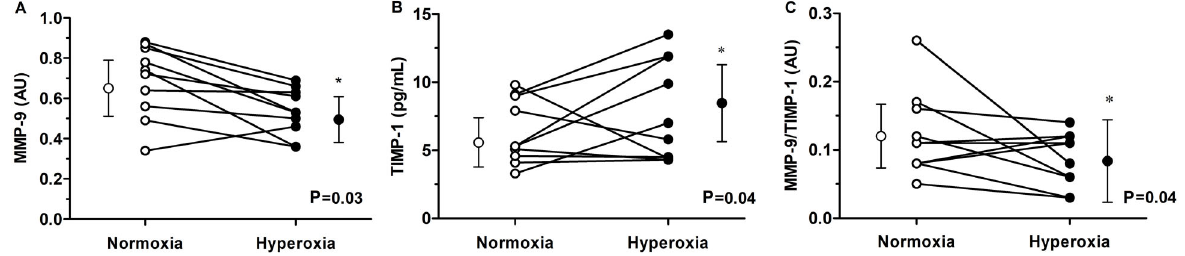
Figure 2. Venous plasma MMP-9 activity ( A ), TIMP-1 levels ( B ), and net MMP-9 activity ( C ) in healthy men (n=10) exposed to normoxia (21% O